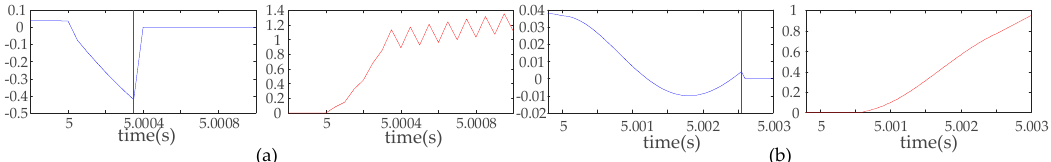
Figure 13. External pole-to-ground faults for PV protection. ( a ) A 3 Ω transient resistance; ( b ) a 5 Ω transient resistance.